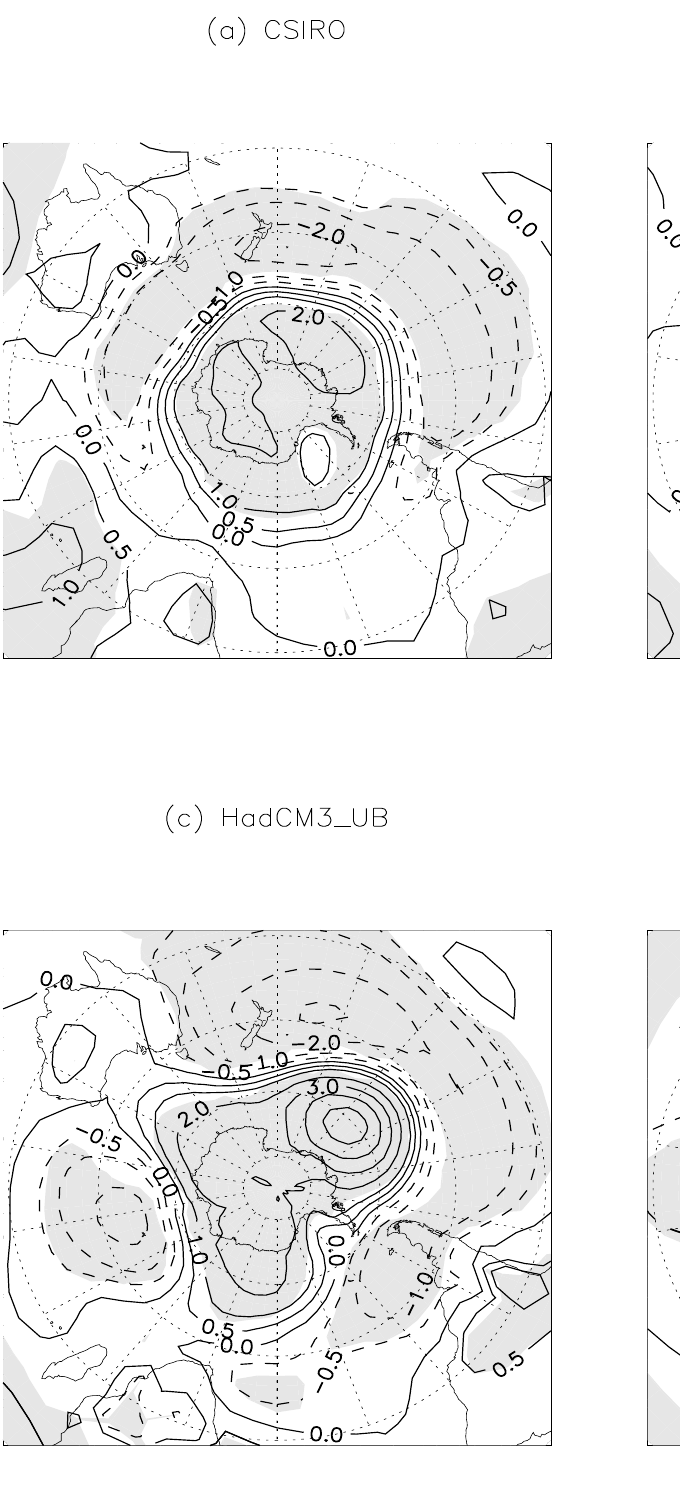
Fig. 4. The same as Fig. 3 except for MAM.